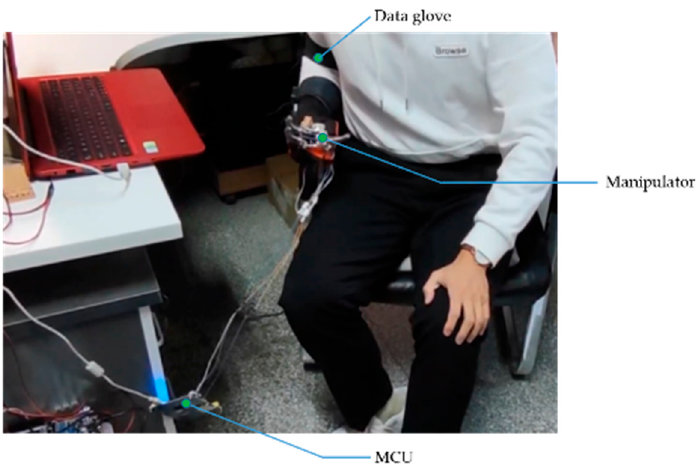
Figure 5. Experimental